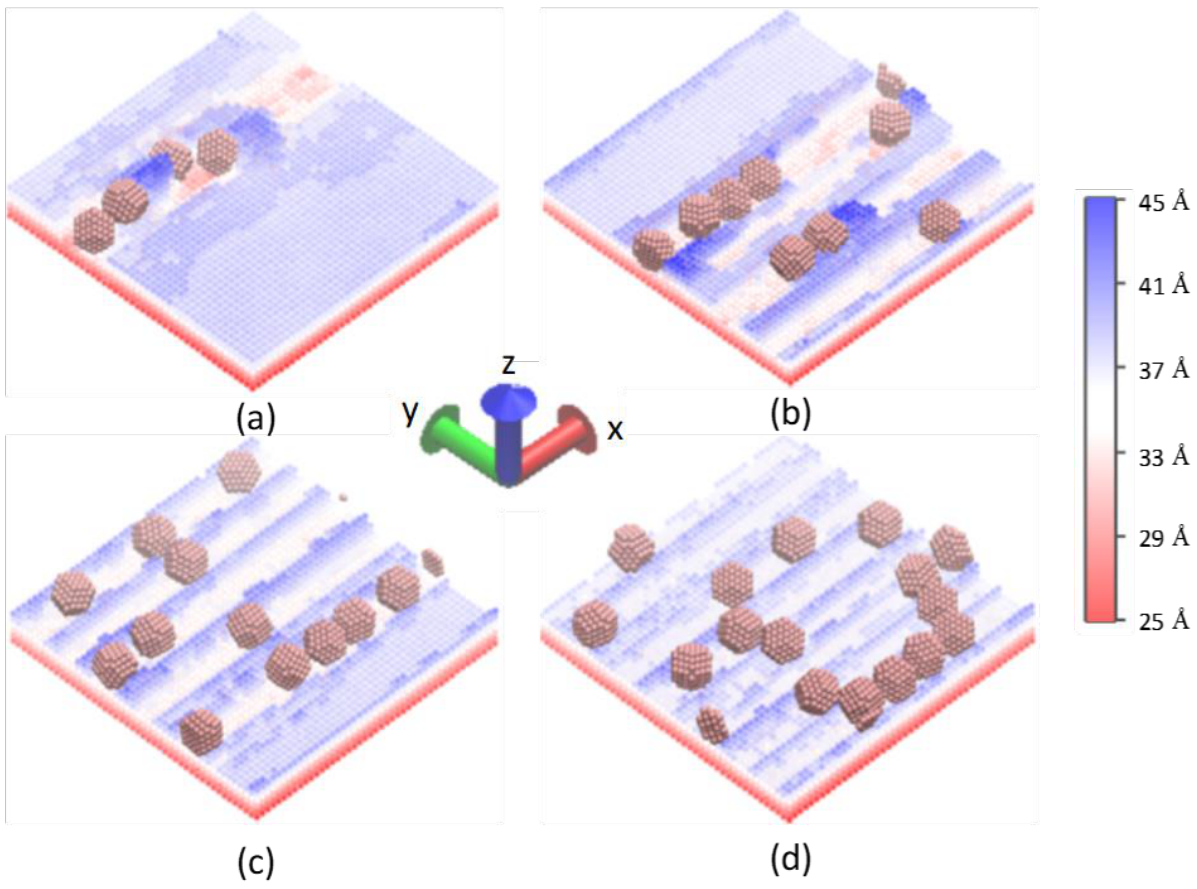
Figure 10. The surface morphology of the lower wall with ( a ) 4, ( b ) 8, ( c ) 12 and ( d ) 16 nanoparticles at 4000 ps. Only the atoms of the lower wall with Z > 25 Å are shown and colored. The normal load applied in the boundary friction system is 1.0 GPa.